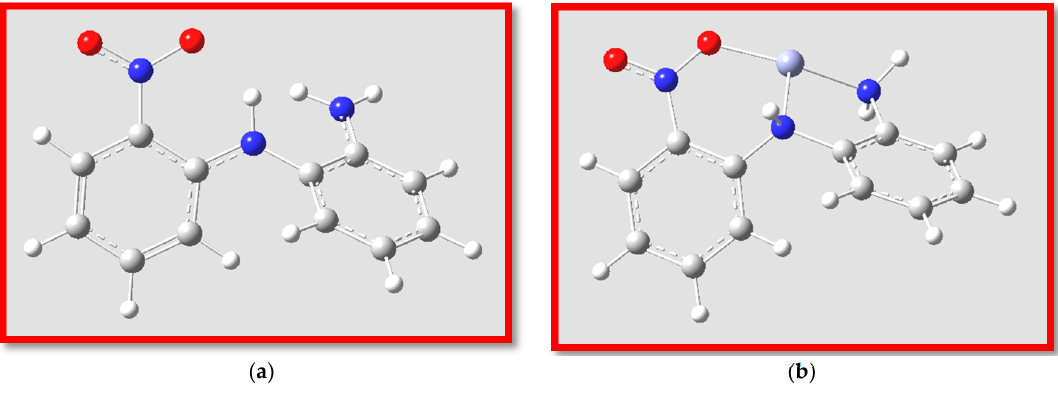
Figure 8. DFT optimized structures of DPA ( a ) and DPA-Zn 2+ complex ( b ). White, red, blue, grey, and purple spheres refer to H, O, N, C, and Zn 2+ , respectively.